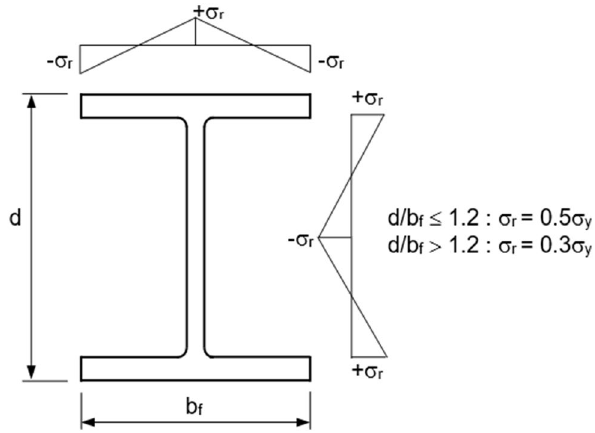
Fig. 2 Assumed residual stresses